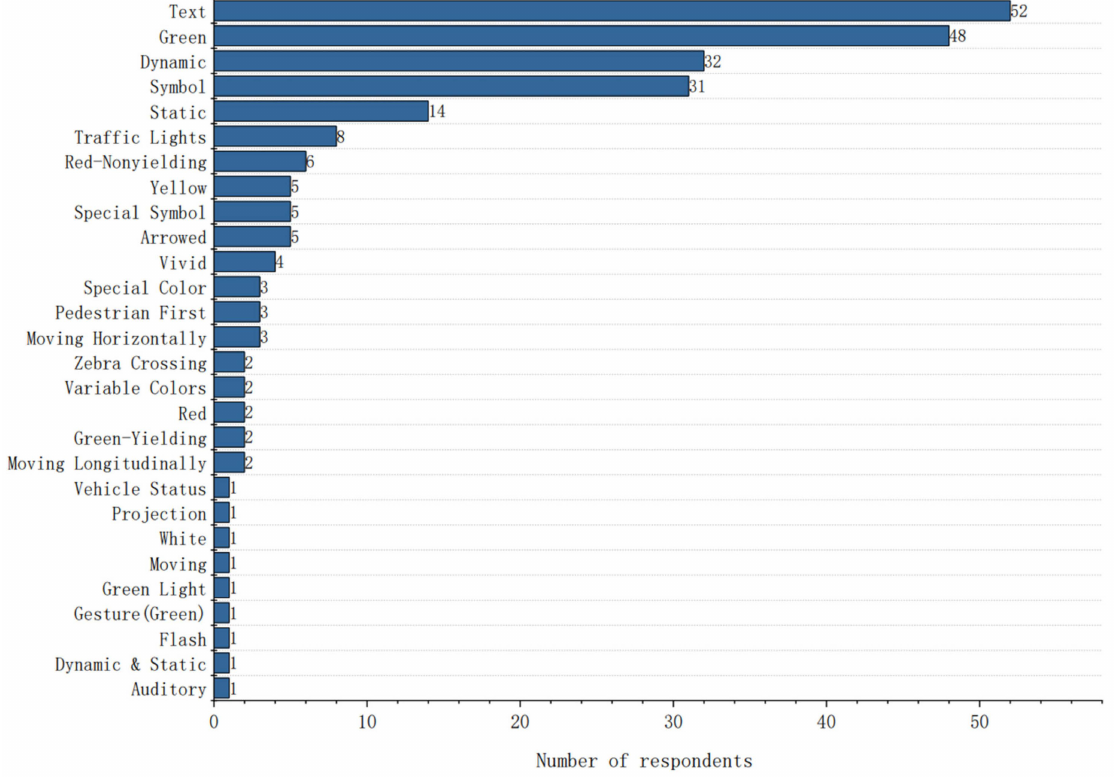
Figure 8. The word frequency statistics of acceptable design elements of